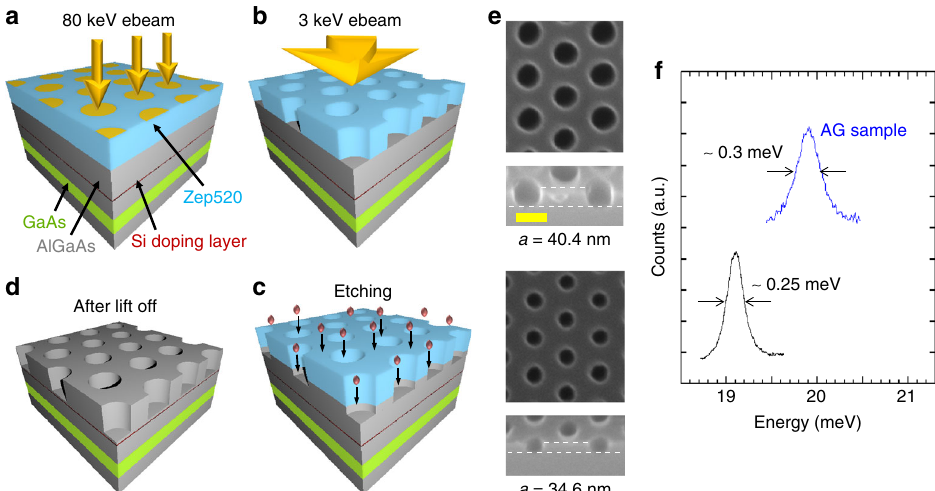
Fig. 2 Creation of arti fi cial graphene in triangular antidot lattices. Processing steps: a a Zep 520 resist is exposed by an electron beam at 80kV accelerating voltage. After exposure, the development of the resist produces triangular antidots pattern. b The resist with pattern is exposed by an electron fl ood at 3kV accelerating voltage, to enhance the chemical stability of the resist. c The BCl 3 -based dry etch is performed to transfer the pattern to the substrate with depth control. The fi nal device after the removal of the residue resist is shown in d . The QW is positioned 80nm below the surface and 30nm below the Si δ -doping layer. The as-grown electron density is 2.1×10 11 cm − 2 , with a Fermi energy E F of 7.5meV and a typical low-temperature mobility of 10 6 cm 2 V − 1 s − 1 . e Scanning electron microscopy micrographs of AG lattices with different periods in 0° tilt (upper panel, top view) and 40° tilt (lower panel, side view). The white dashed lines de fi ne the etching depth. The yellow scale bar is 50nm for all panels in e . f The comparison between the RILS spectrum of intersubband excitations of AG sample I (with incident photon energy of 1554.36meV, blue trace) and intersubband excitations of the as-grown GaAs QW (with incident photon energy of 1550.92meV, black trace). The peak width of intersubband excitations of sample I is nearly constant for different incident photon energies (see Supplementary Note 5 and Supplementary Figure 8). The spectra were taken at 5K under crossed